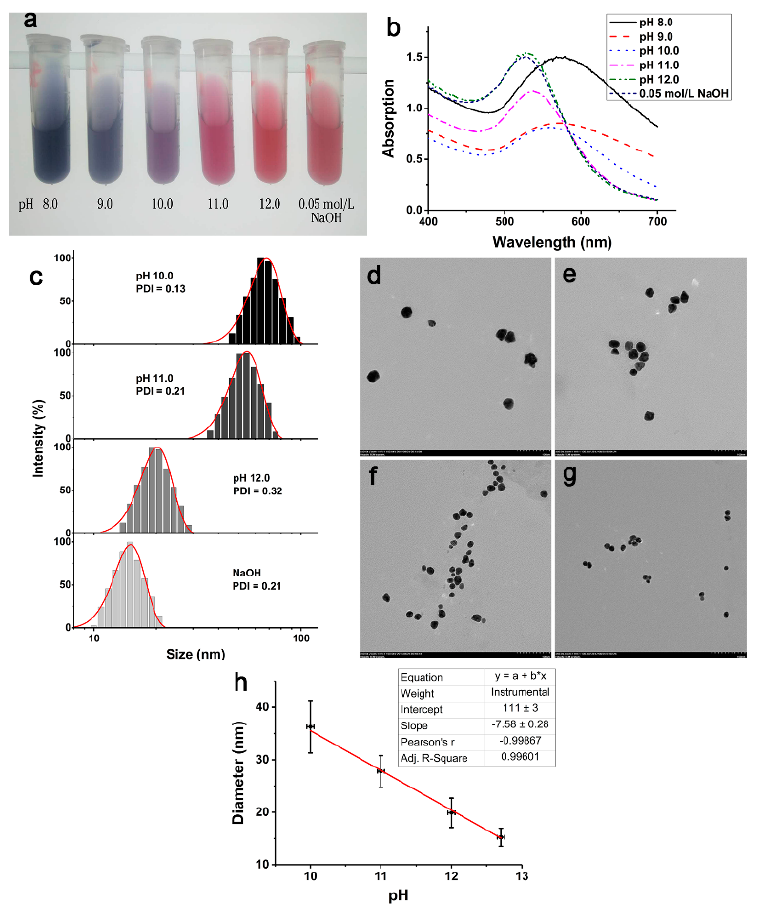
Figure 5. Picture of the products prepared by dissolving tyrosine at different pHs ( a ) and the corresponding UV–vis absorption spectra ( b ). ( c ) DLS and ( d – g ) TEM images of CALNN-coated AuNPs obtained at pH 10.0, 11.0 12.0 and 0.05 mol / L NaOH, respectively. ( h ) Relationship between the size and pH of tyrosine solutions.